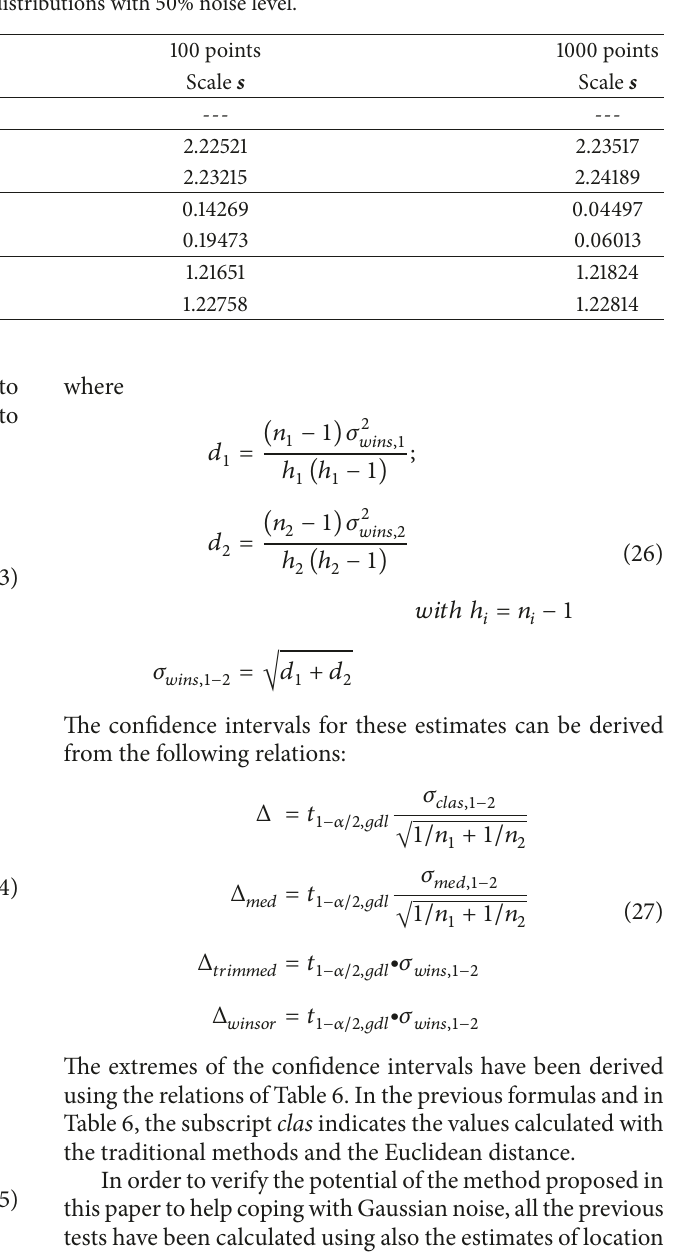
Table 35: Exponential distributions with 50% noise